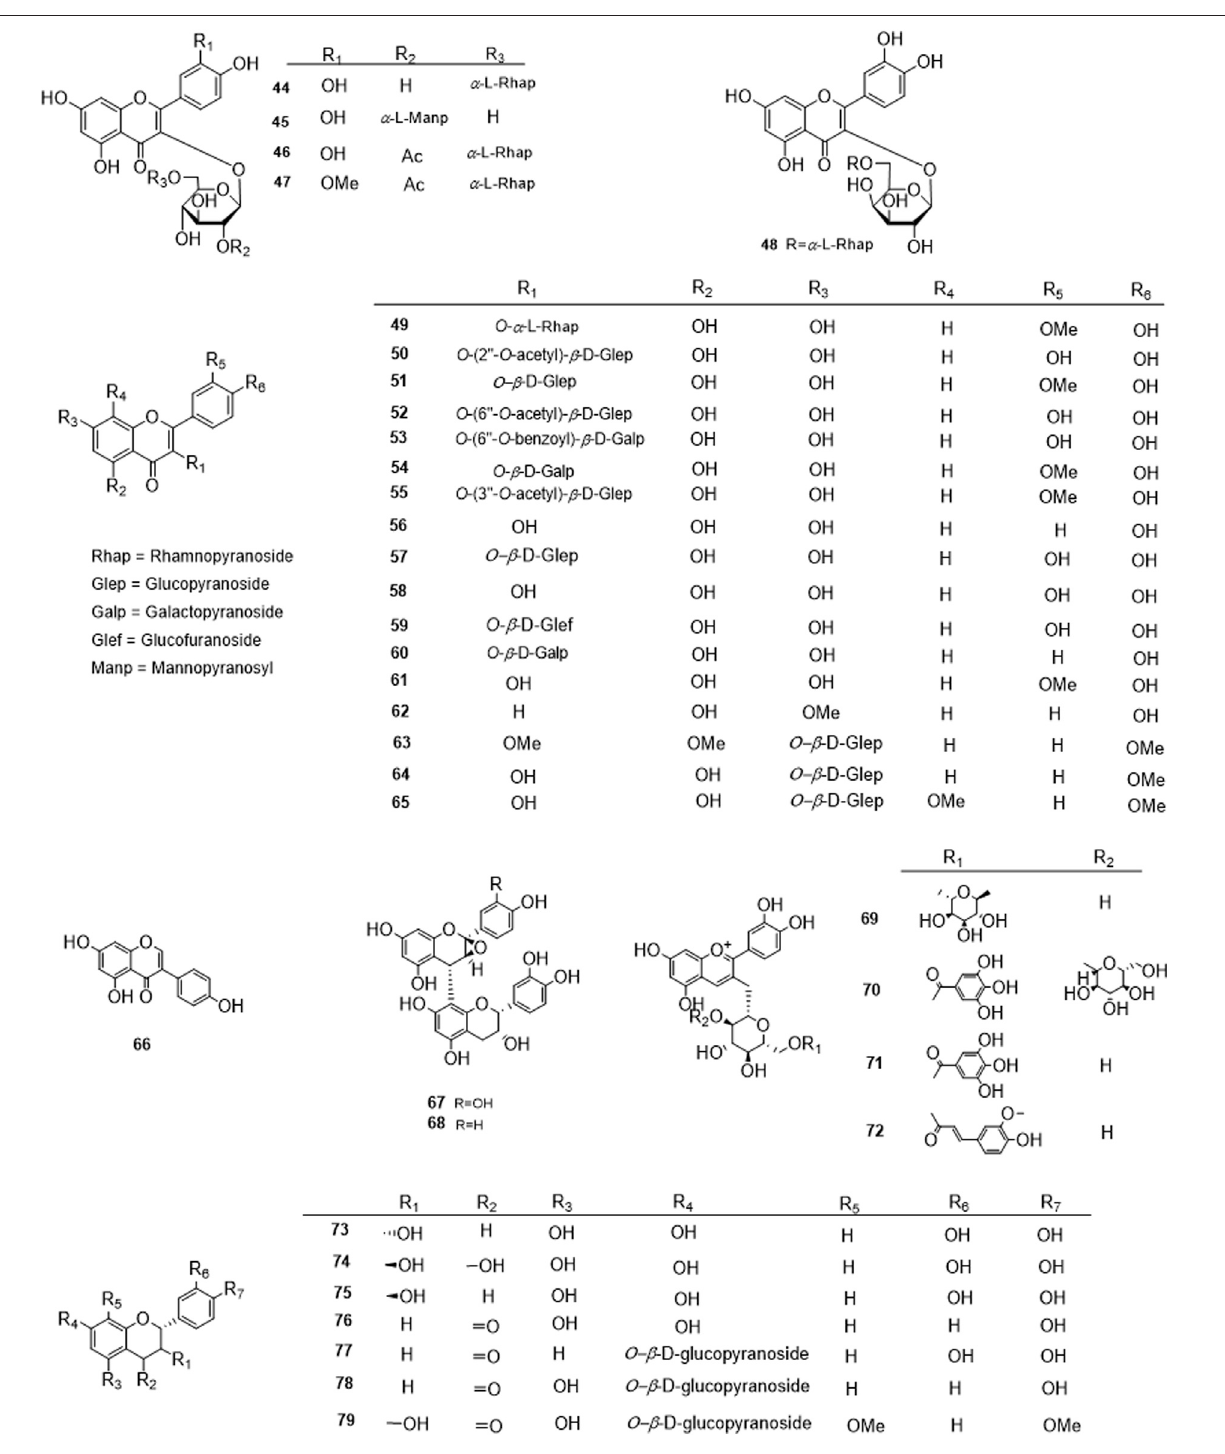
Frontiers in Pharmacology |